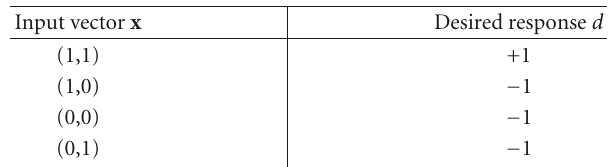
Table 2: AND problem for classifying voltage dips due to